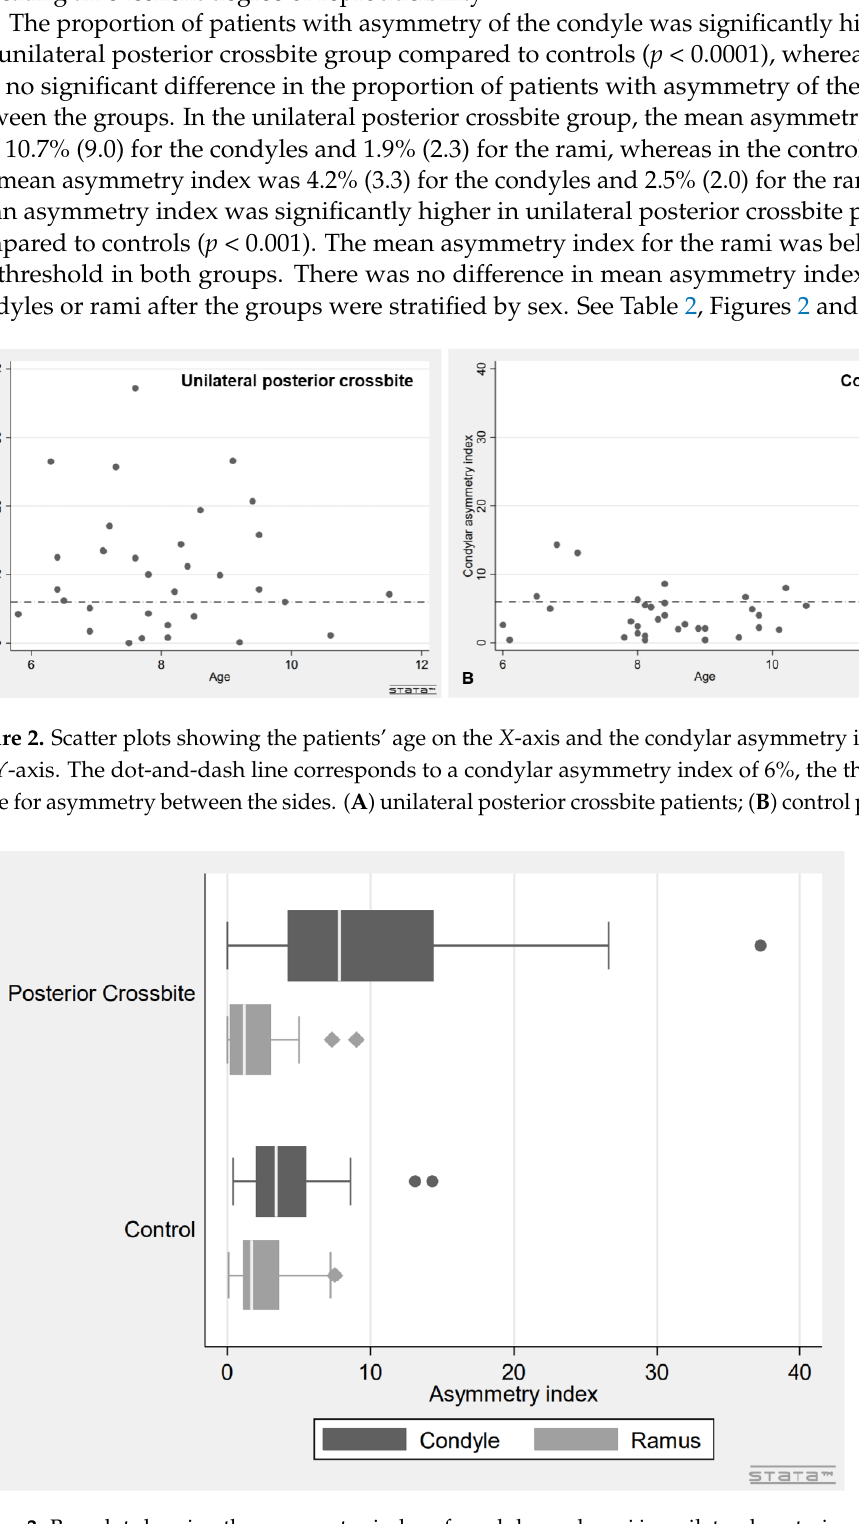
Figure 3. Box plot showing the asymmetry index of condyles and rami in unilateral posterior crossbite patients and controls. Dots and diamonds represent outliers (dots: condyle; diamonds: ramus). Note the significantly higher condylar asymmetry index in unilateral posterior crossbite patients.